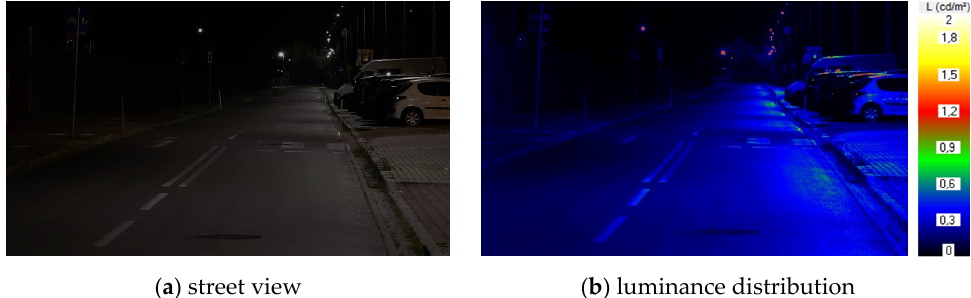
Figure 22. View of the street with lighting when the luminous flux Φ of the lamps is controlled to 33% (average luminance of the roadway is Lav = 0.25 cd/m 2 ).